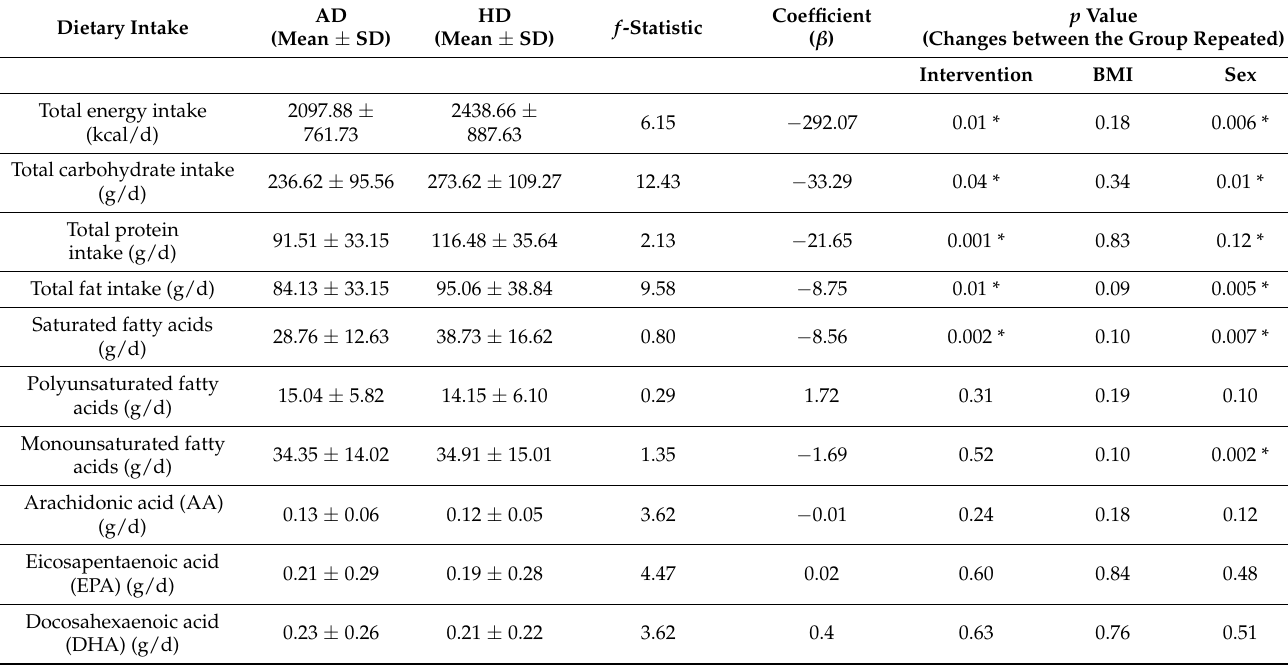
Table 2. Coefficient estimates from GLMM analyses for dietary intake at the end of each phase following adequate dairy product intake (AD) and high dairy product intake (HD) in subjects with